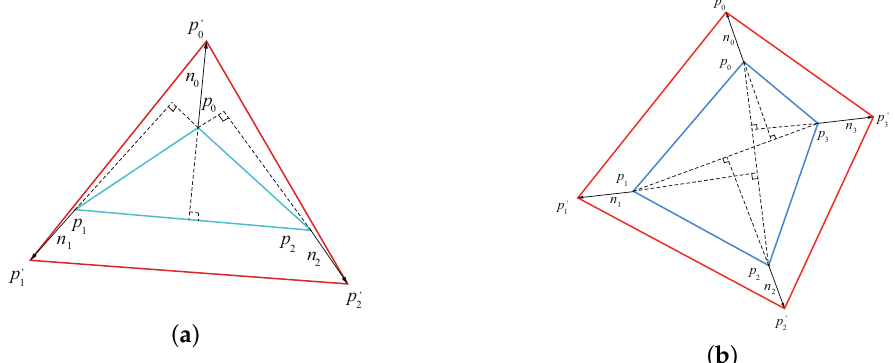
Figure 1. ( a ) The stretching operation of triangular elements in Reference [30]. ( b ) The stretching operation of quadrilateral elements in Reference [30].